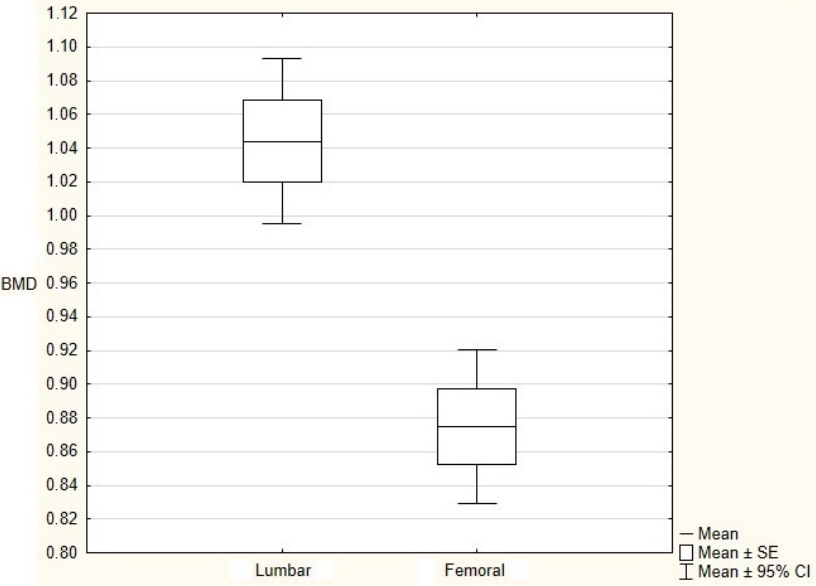
Figure 1. Femoral and lumbar bone mineral density (BMD).